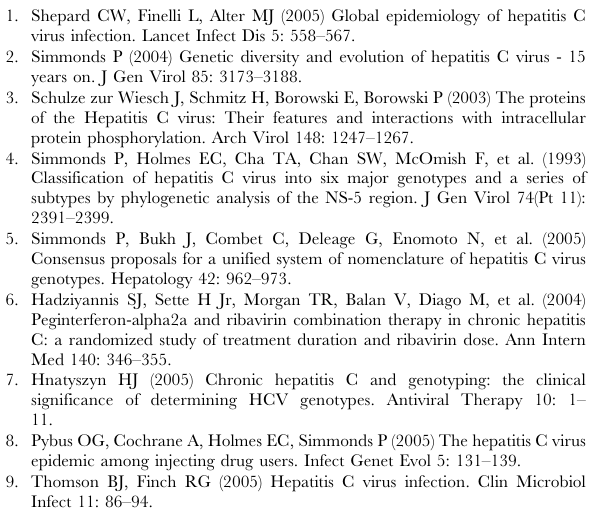
Table S1 Detailed information on patients, samples, sequences and accession numbers used in this research